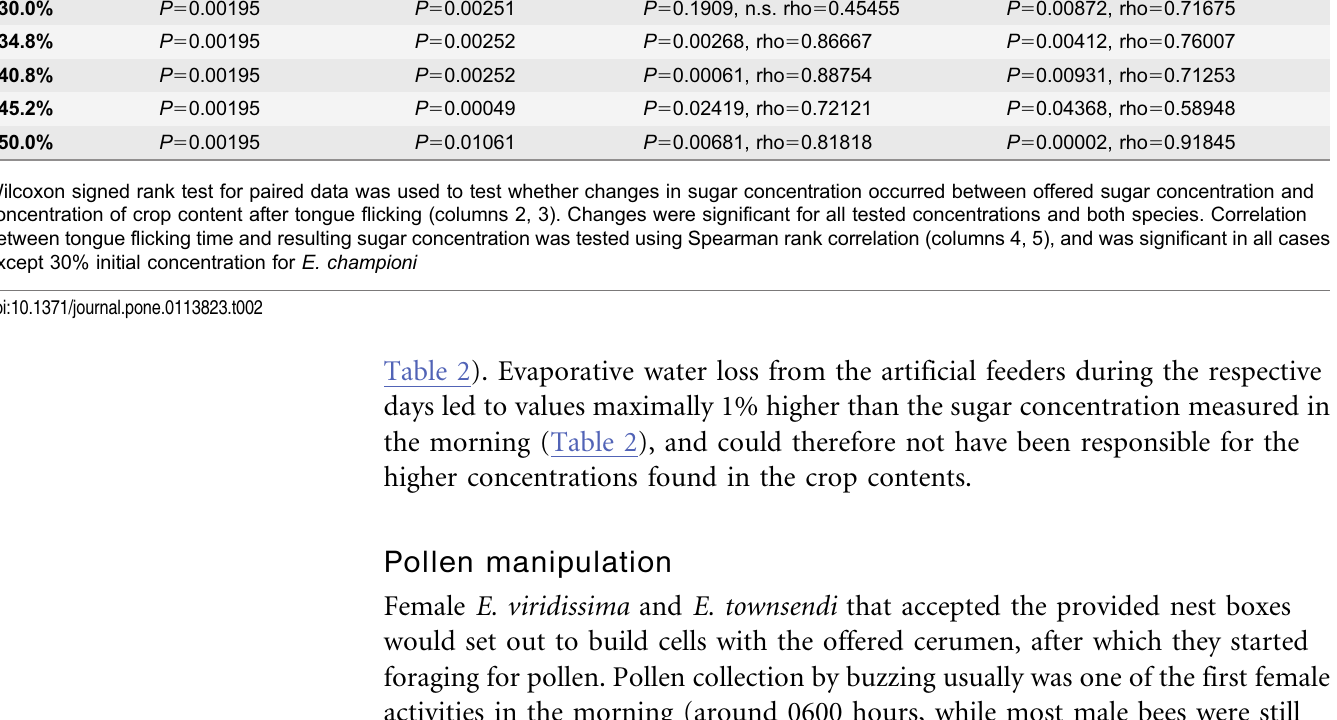
Table 2. Results of statistical tests on effects of tongue flicking behavior.